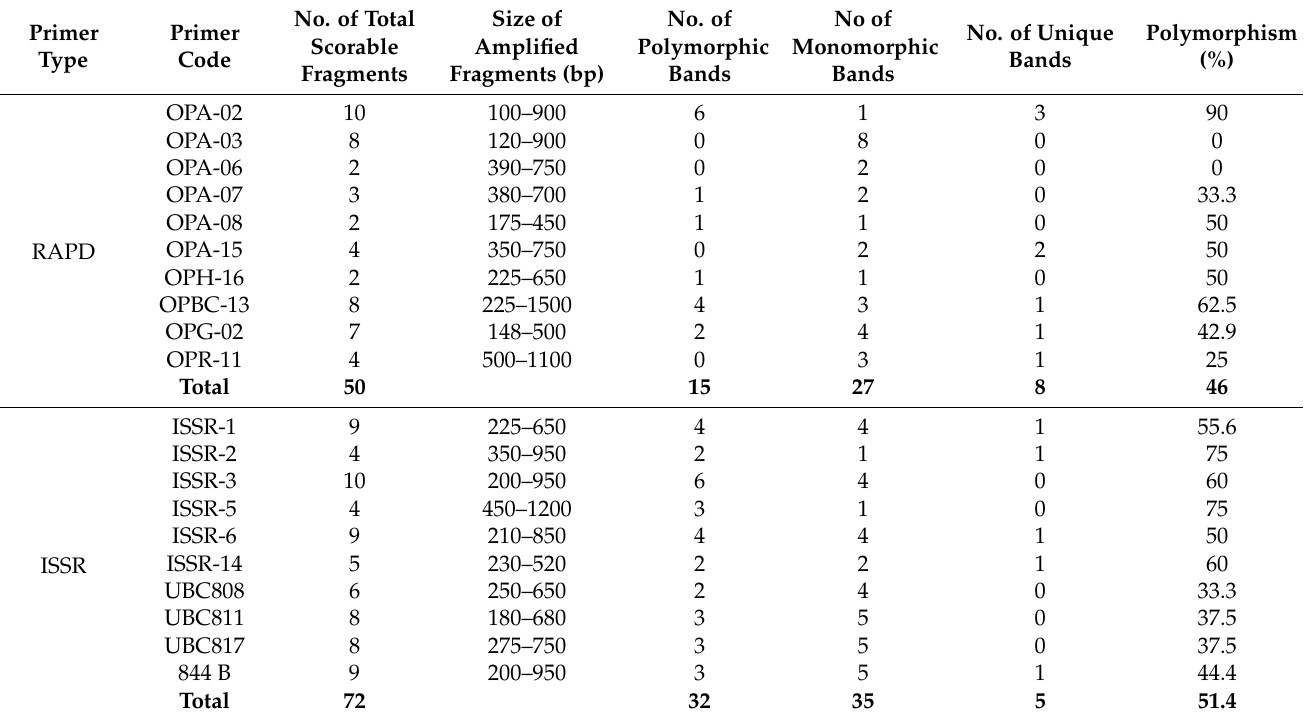
Table 11. RAPD and ISSR analysis to detect somaclonal variation among different NaCl-tolerant selected lines obtained from plants subjected to long-term culture and NaCl on semisolid MS medium containing 2 mg/L BAP and 0.1 mg/L NAA. Control shoot cutting was also